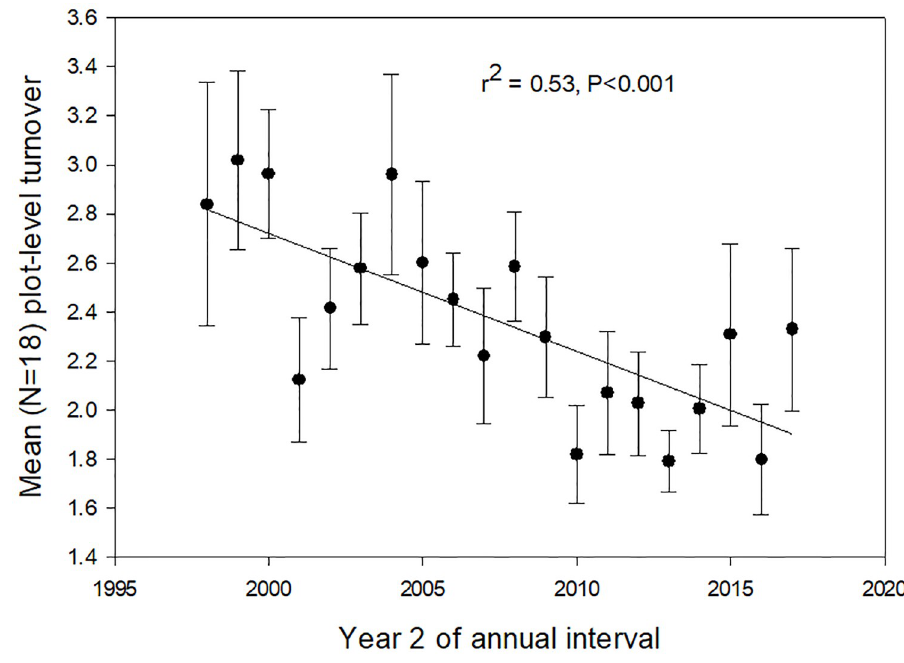
Fig 7. Turnover. Mean annual turnover (the average of annual recruitment and annual mortality) for all stems � 10 cm diameter in 18 0.5-ha plots in old-growth tropical rain forest, La Selva Biological Station, Costa Rica, 1997–2017. Error bars are ± 1